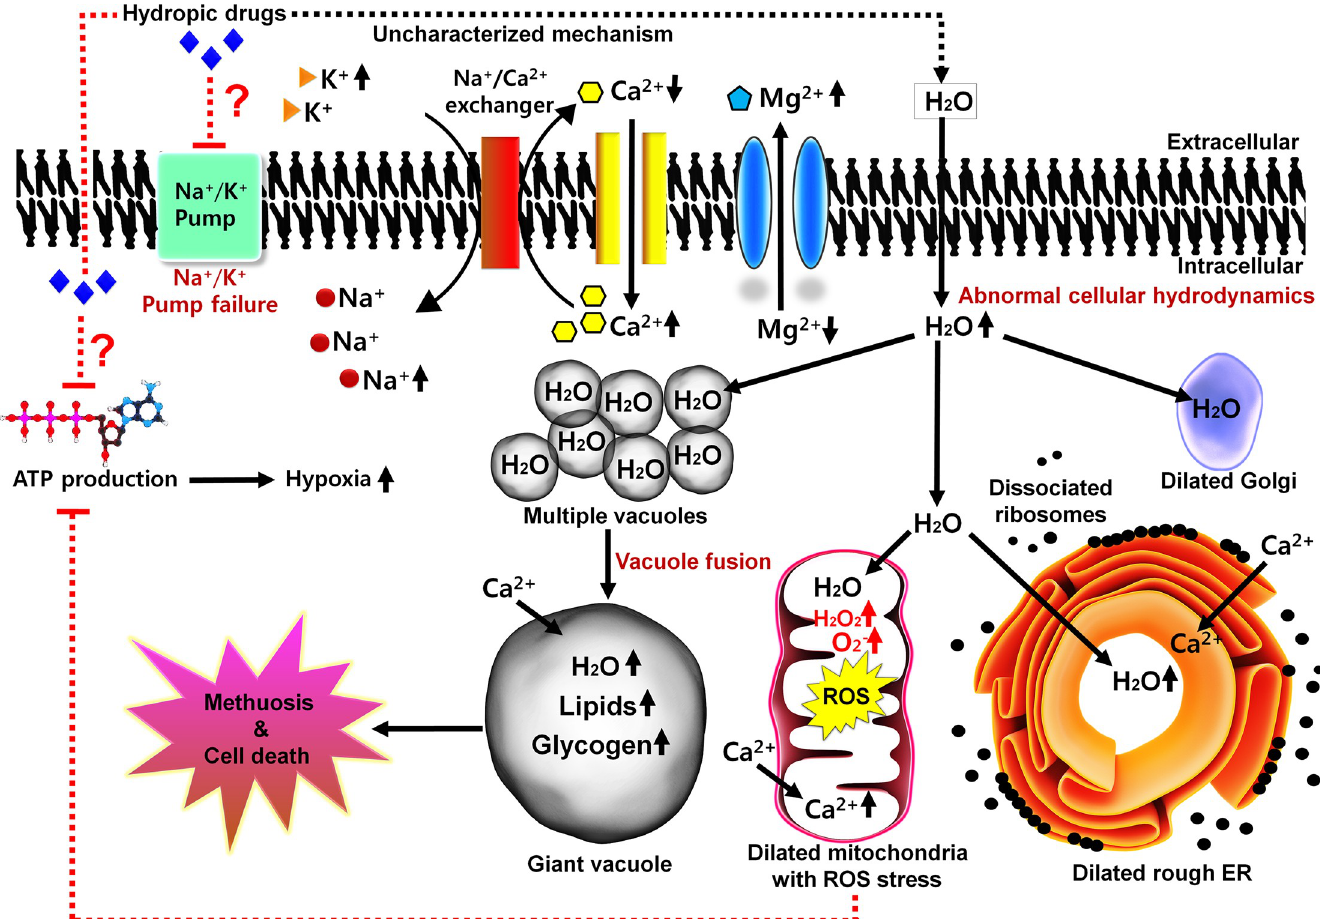
Fig 1. Biochemical changes that occur in a dying cell with disrupted osmoregulation. It is believed that hydropic drugs might inactivate the Na + /K + antiporter pump or alternatively lead to decreased ATP production, ultimately leading to accumulation of Na + , Ca 2+ , and water and effluxes of K + and Mg 2+ . A decreased Mg 2+ level also suggests impaired functioning of the Na + /K + pump. The drug might cause a rapid influx of water by an as of yet unknown mechanism, causing organelles (vacuoles, Golgi bodies, mitochondria, and rough endoplasmic reticulum) to dilate extensively and disrupting normal biological functioning. Water-filled vacuoles tend to fuse to form giant vacuoles that subsequently rupture and kill cells. Contrariwise, mitochondrial damage might also be a factor for decreased ATP production in the cell. The dashed lines (red or black) indicate uncharacterized sections of the pathway, while solid lines (black) represent regular biological attributes. ATP, adenosine triphosphate; ER, endoplasmic reticulum; ROS, reactive oxygen